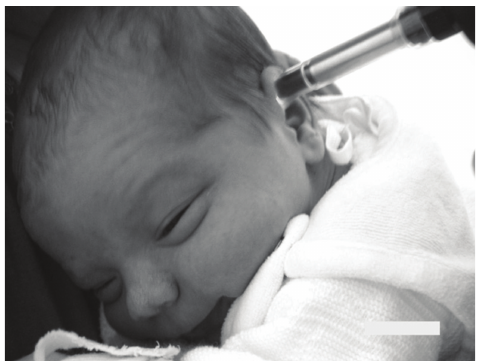
F 1: Obtaining OPS images from the ear